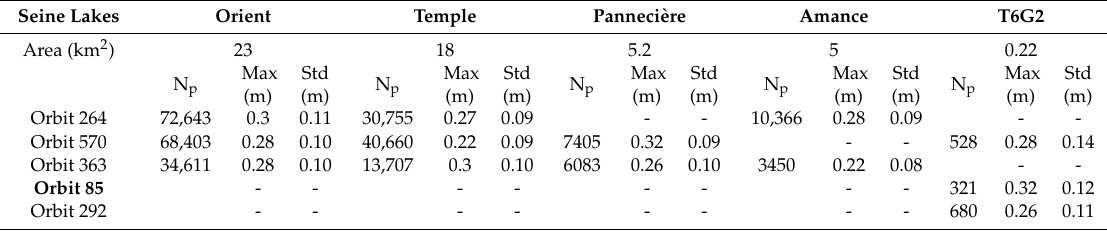
Table 2. Standard (Std) and maximal (Max) SWOT-like water surface elevation (WSE) errors (in meters) simulated for the four studied reservoirs of the Seine and the T6G2 gravel pit. Surface extent in km 2 and average number of SWOT pixels (N p ) are given for each water body.